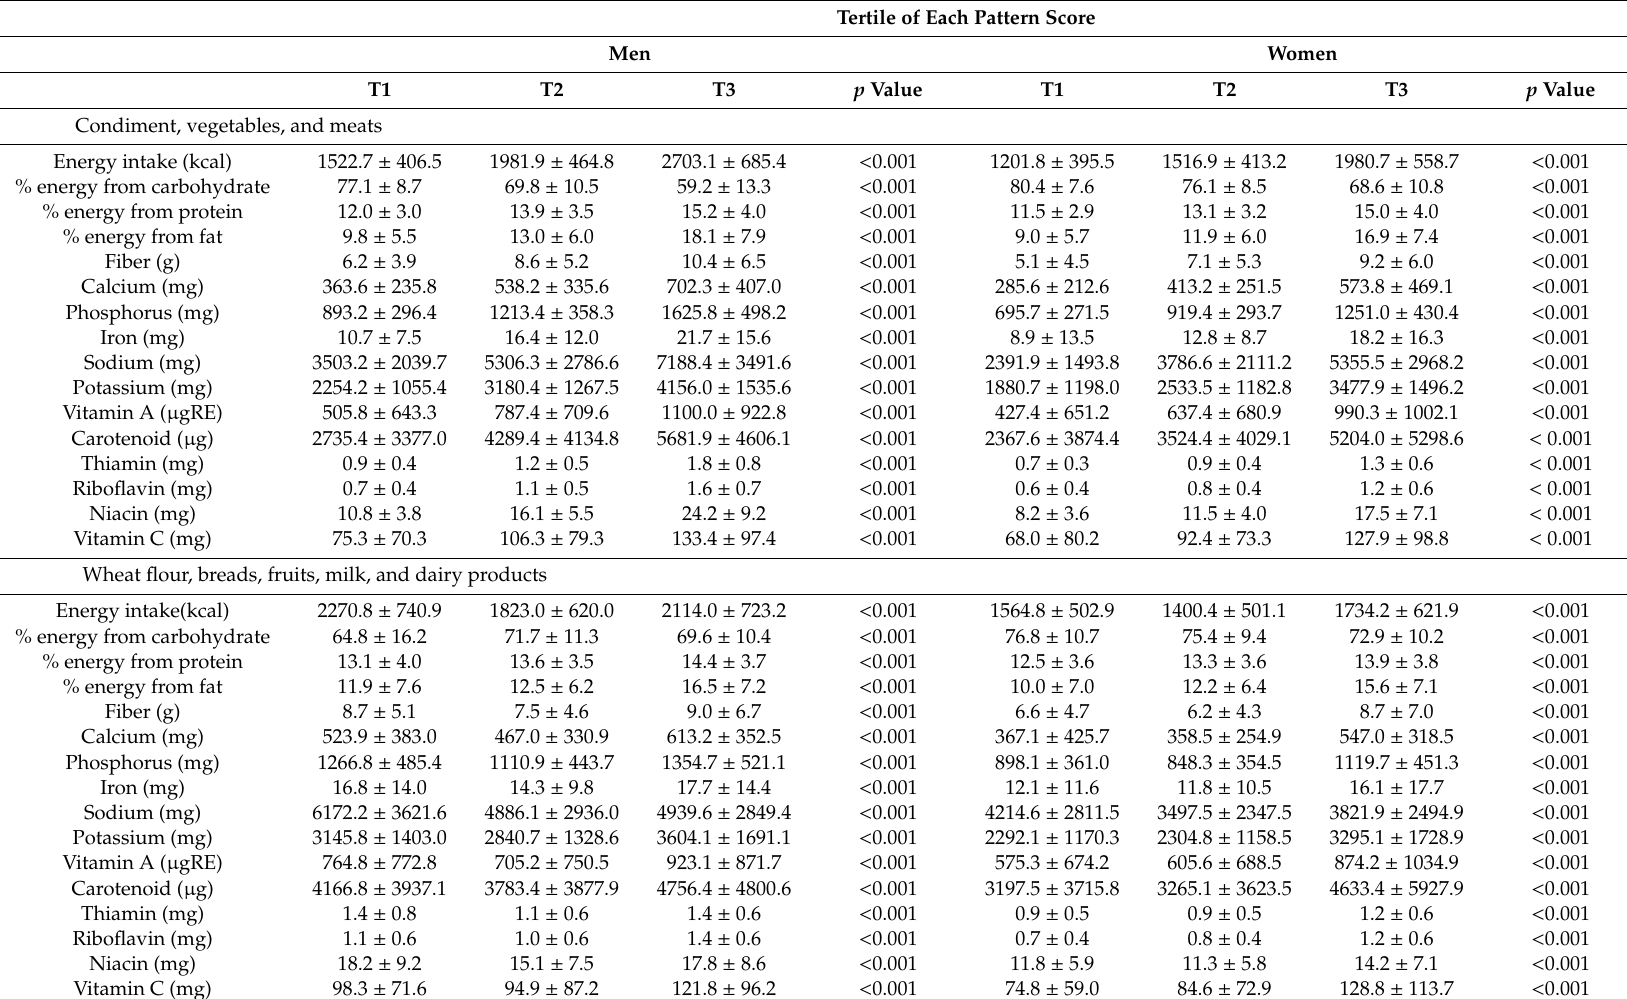
Table 2. Nutrient intakes of study participants according to the tertiles of each dietary pattern score by